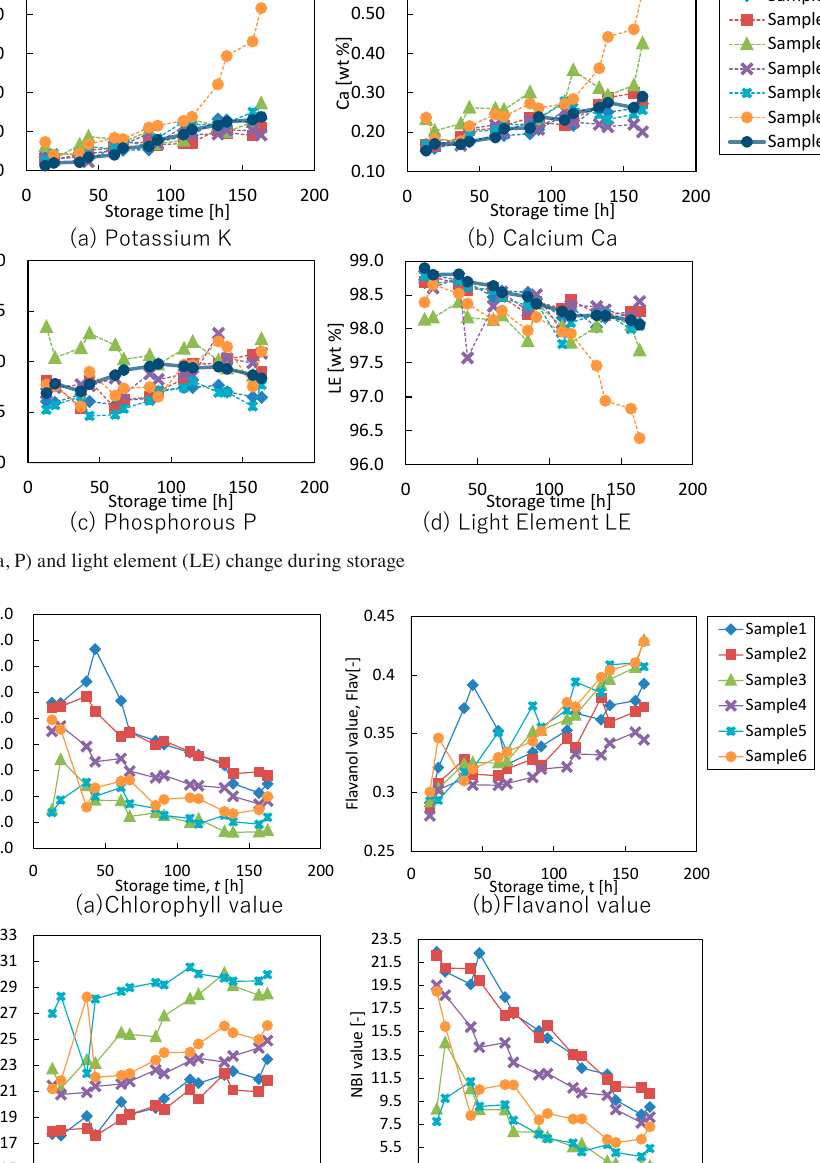
FFiigg.. 1155 PPiiggmmeenntt ((CChhll,, FFllaavv,, AAnntthh,, NNBBII)) cchhaannggee 718